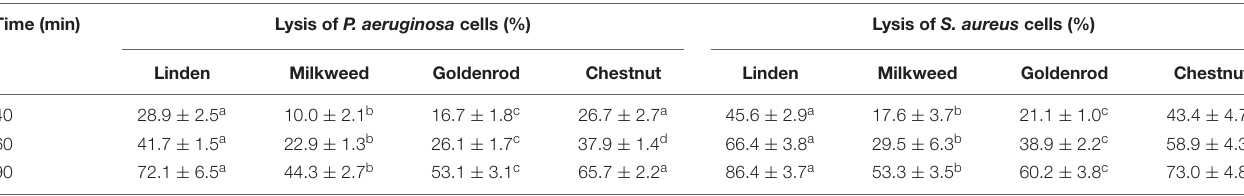
TABLE 6 | Kinetics of 260-nm absorbing material release from P. aeruginosa and S. aureus treated with 60% ( w/v ) honey solutions. Time (min)